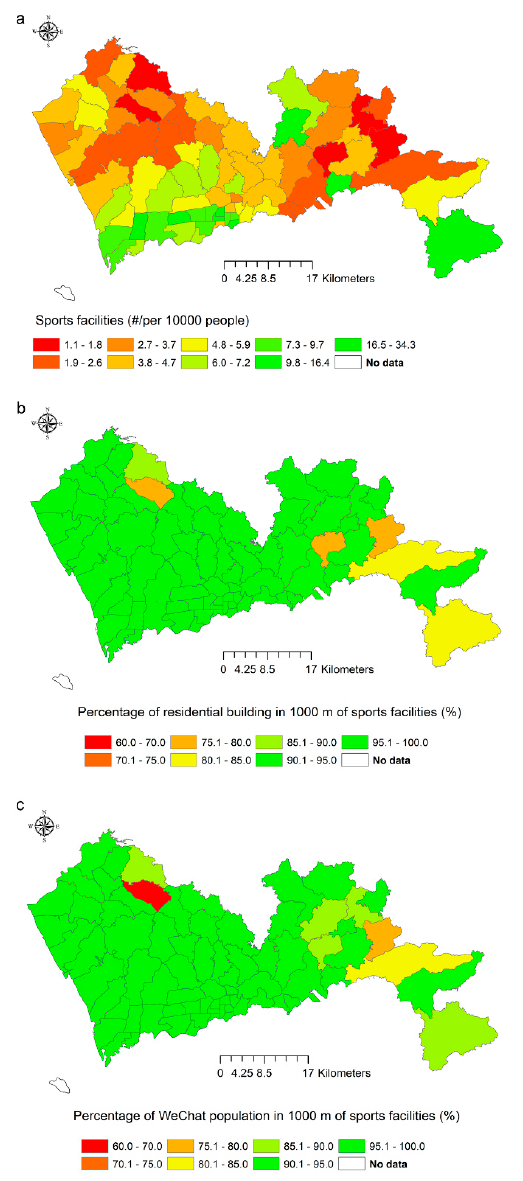
Figure 4. Values of the indicator of sports facilities in 74 sub-districts. ( a ) The number of sports facilities per 10,000 people; ( b ) the percentage of residential buildings ≤ 1000 m to sports facilities; ( c ) the percentage of WeChat population ≤ 1000 m to sports facilities.